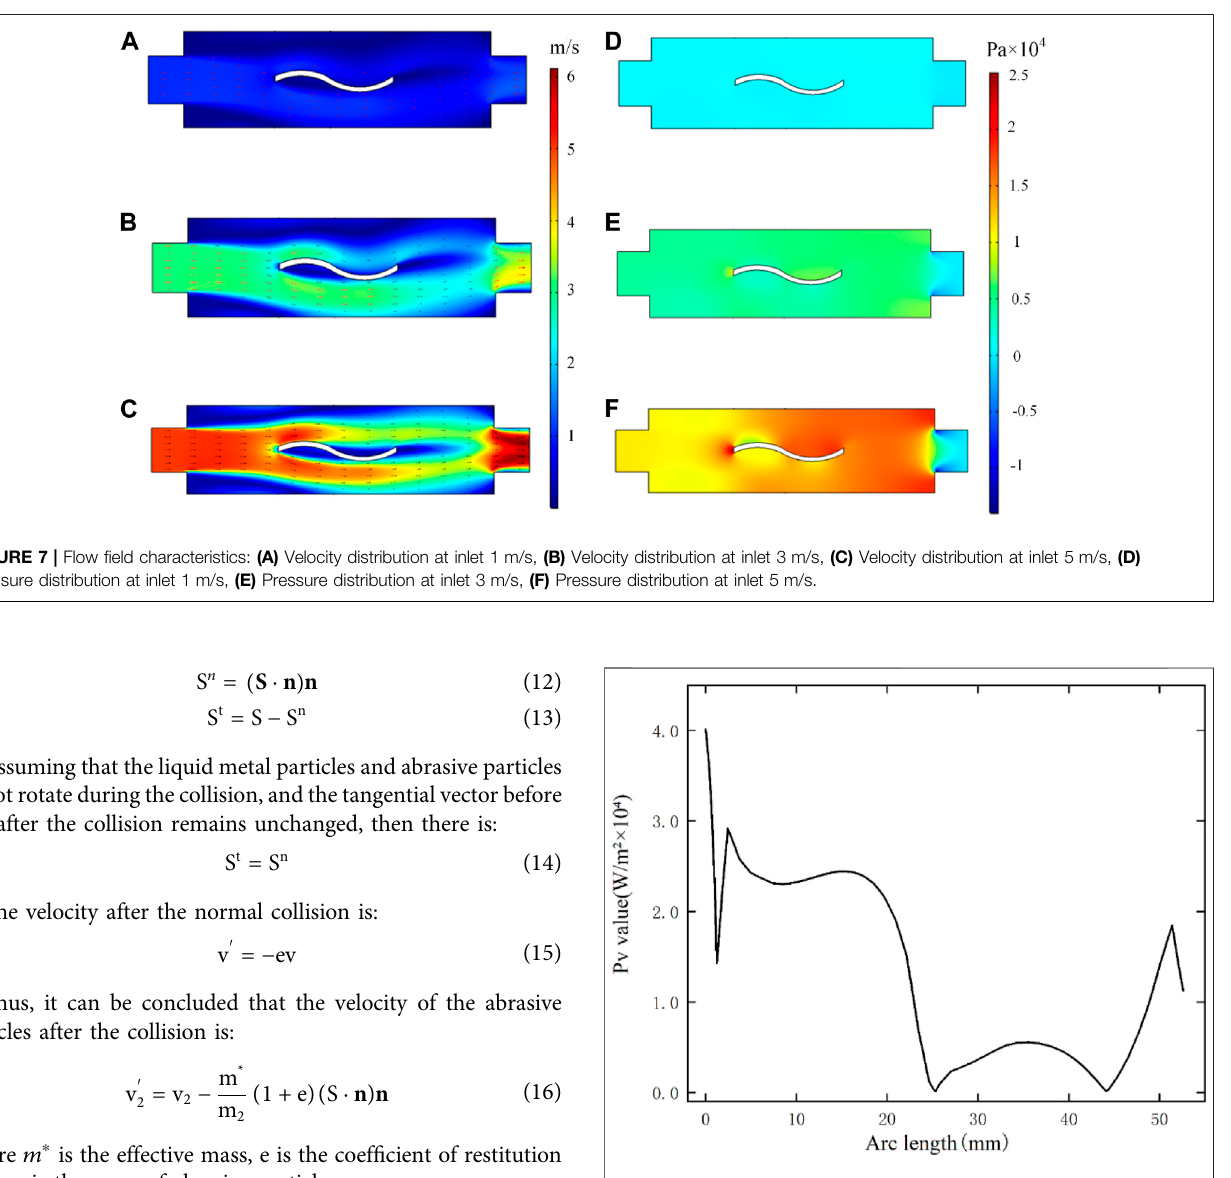
FIGURE 8 | Pv value of fl ow fi eld on the target